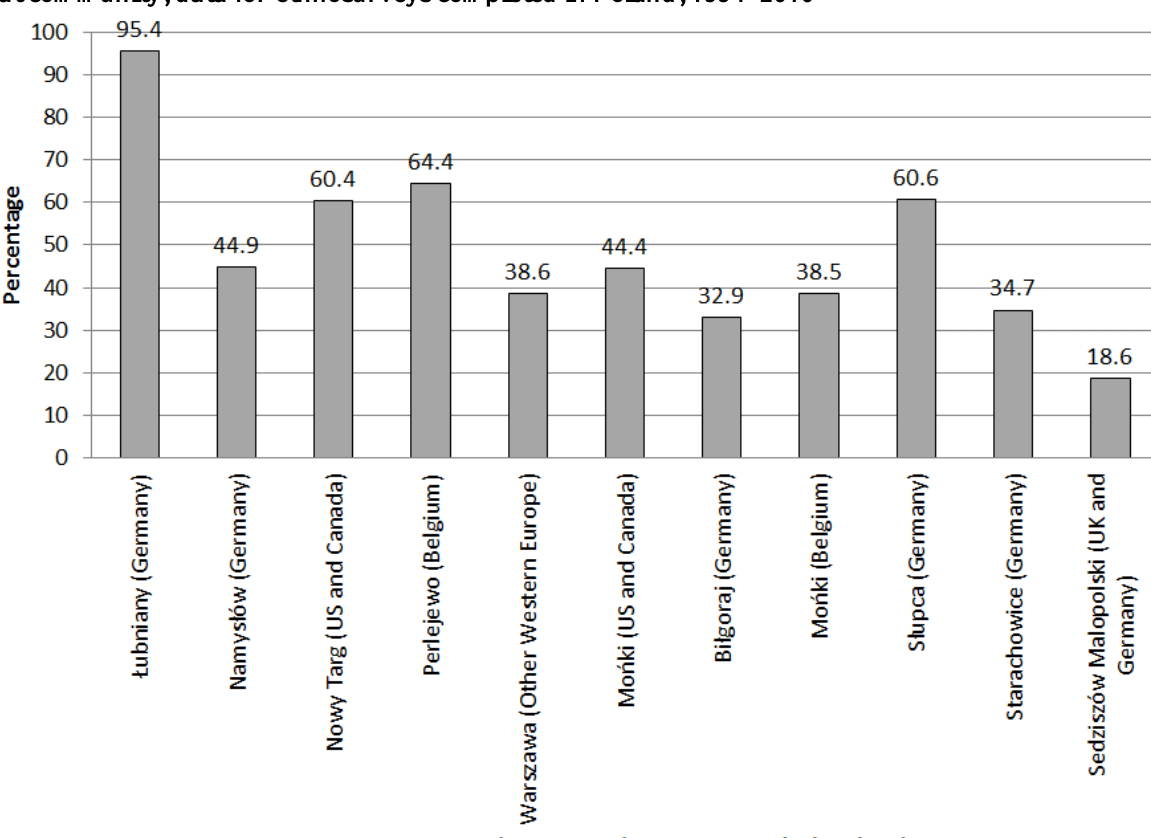
Figure 4. Share of migrants from a given community residing in the most important destination for that community, data for ethnosurveys completed in Poland,